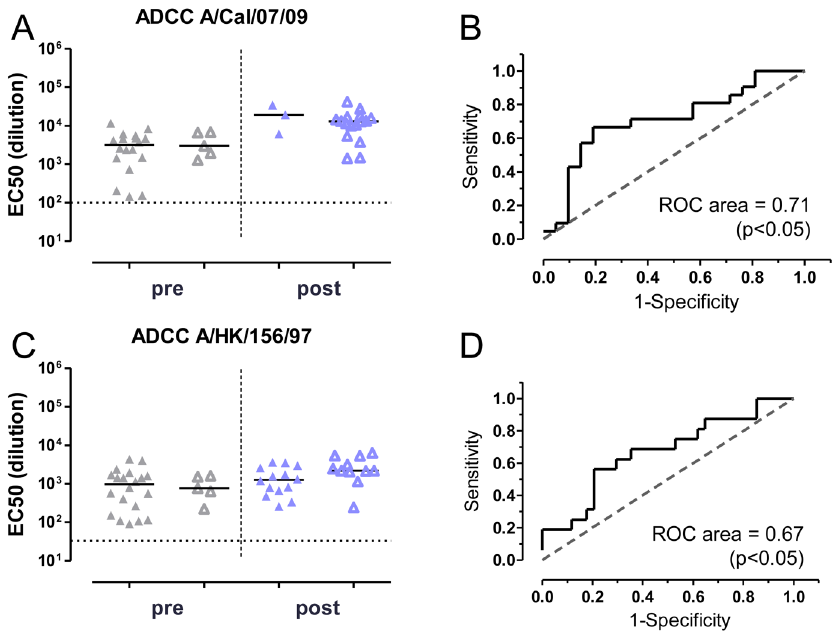
Figure 5. Serum ADCC titers weakly correlate with protection against H1N1 and H5N1 challenges. ADCC titers against ( A ) A/California/ 07/2009 (H1N1) and ( C ) A/Hong Kong/156/97 (H5N1) were determined. Titers for mice that survive challenge (open triangles) and mice that succumb to infection (closed triangles) are presented separately for pre-vaccination (pre) and post-vaccination (post) sera. Assay background level is indicated with dashed line in panels A and C. Vaccine homologous H1 ADCC titers are higher in post-vaccination serum (p , 0.001, t-test). H5 ADCC titers are detectable in pre-vaccination samples and increase significantly after vaccination (p , 0.001, t-test). ROC curves were calculated to assess the correlation ( B ) between H1N1 ADCC titer and protection against homologous H1N1 challenge (ROC area=0.71, p , 0.05, 95% CI 0.55–0.87) and ( D ) between H5N1 ADCC titer and protection against H5N1 challenge (ROC area=0.67, p , 0.05, 95% CI 0.505–0.84).